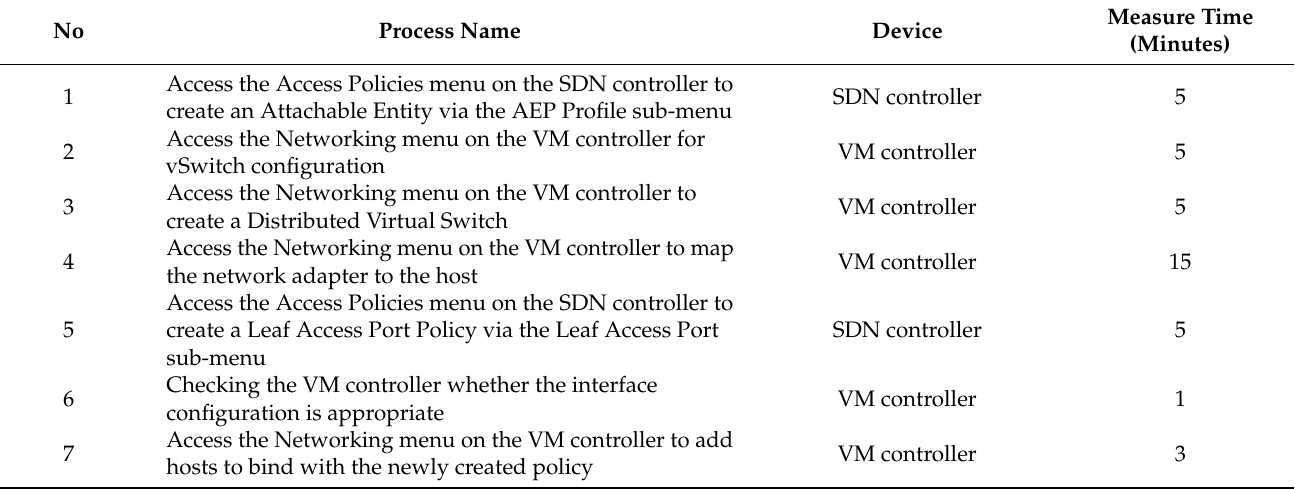
Table 11. Measuring time of policy increments with non-integrated SDN controller and VM